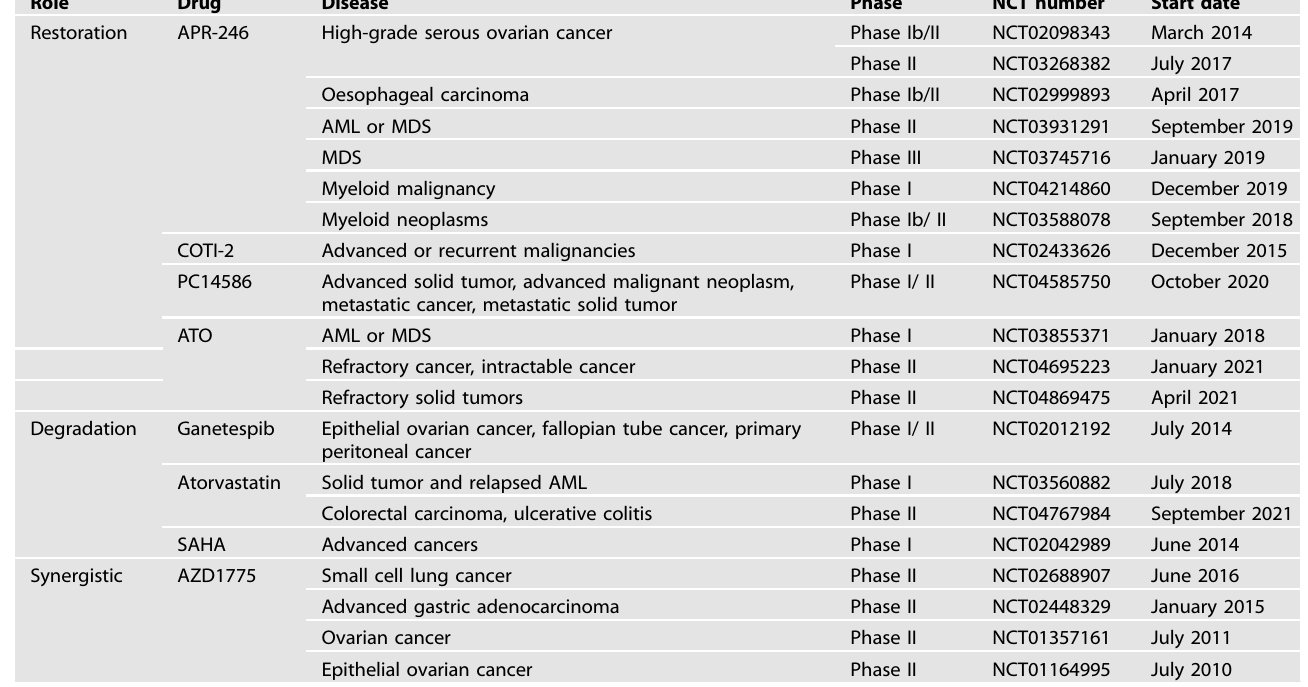
Table 2. Clinical trial drug for targeting cancer cells carrying